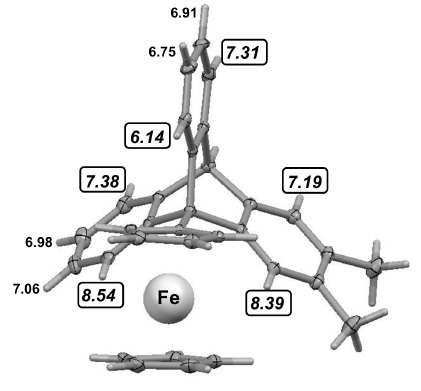
Figure 20. 1 H NMR chemical shifts (ppm) in 2,3-dimethyl-9-ferrocenyltriptycene.